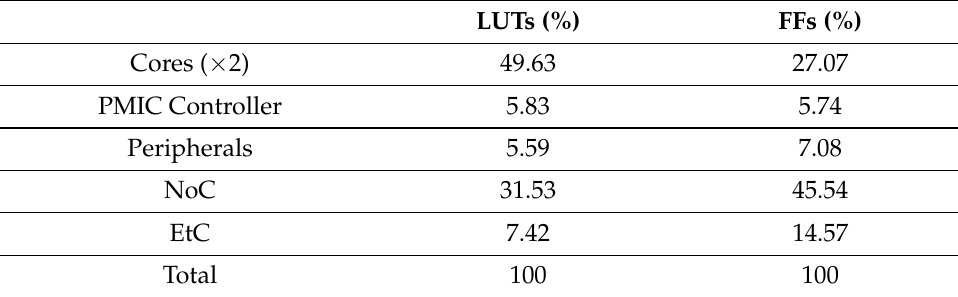
Figure 9. Simulation with FPGA prototyping. Table 3. Resource consumption proportion on the